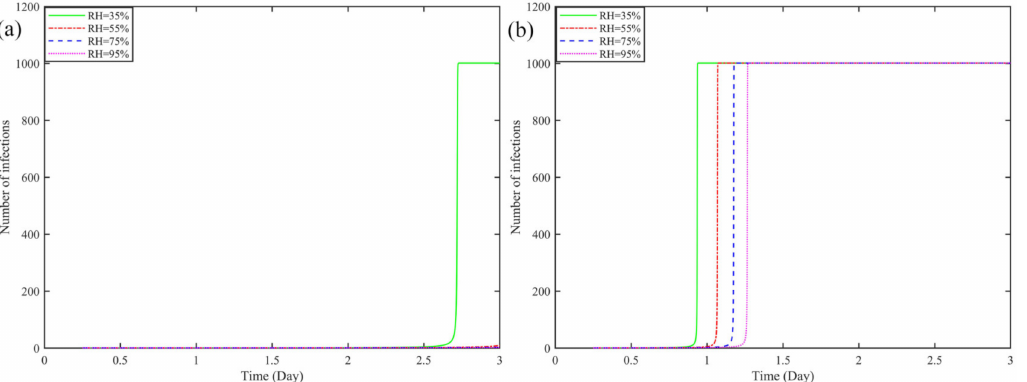
Figure 2. Effect of humidity change on virus transmission in express boxes when ( a ) sterilized and T = 30 ◦ C, ( b ) unsterilized and T = 10 ◦ C (The subfigures show the lines represented by the different relative